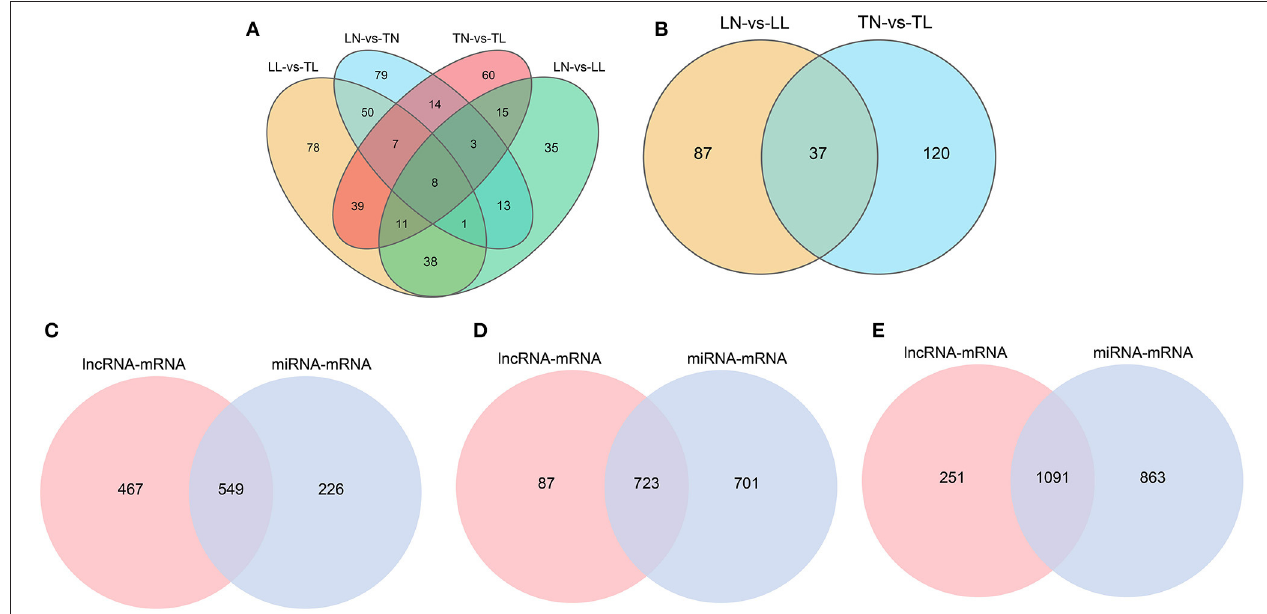
FIGURE 2 | Features of the miRNAs in ATII cells among the four groups. (A) Venn diagram of miRNAs interactions based on the overlapping DEmiRNAs. (B) Common DEmiRNAs shared between the normoxic (TN and LN) and hypoxic (TL and LL) groups. (C) Venn diagram of mRNAs interactions from lncRNA-mRNA and miRNA-mRNA pairs between the normoxic (TN and LN) and hypoxic (TL and LL) groups. (D) Venn diagram of mRNAs interactions from lncRNA-mRNA and miRNA-mRNA pairs between the TN and TL groups. (E) Venn diagram of mRNAs interactions from lncRNA-mRNA and miRNA-mRNA pairs between the LN and LL groups.